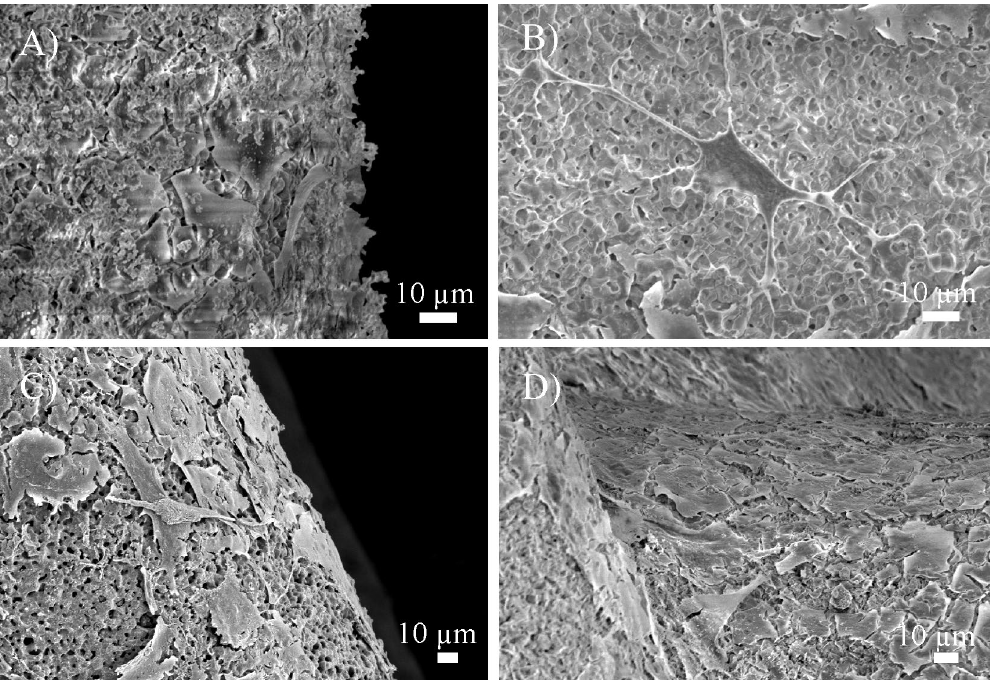
Figure 4. SEM images of the attached osteoblasts on the scaffolds of the Bone Portion after ( A ) 3, ( B ) 7, ( C ) 14 and ( D ) 21